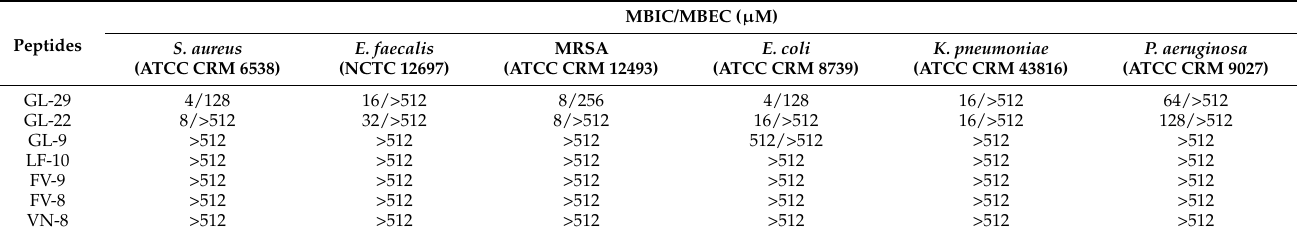
Table 3. The MBICs and MBECs of GL-29 and its analogues against reference